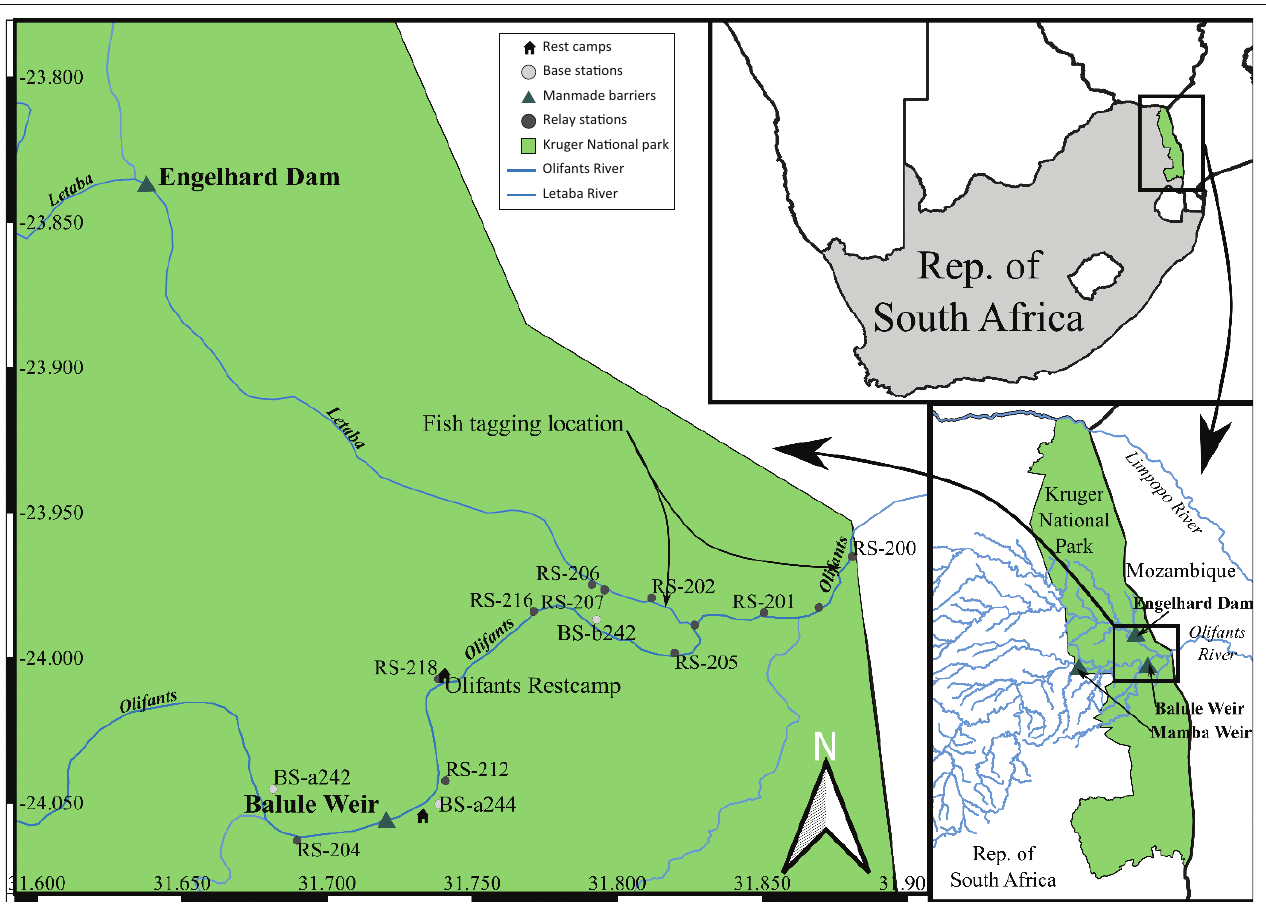
FIGURE 1: The Kruger National Park within South Africa and the positioning of the remote network consisting of base and relay stations. The hydrological gauging weirs at Balule and Engelhardt on the Olifants and Letaba Rivers, respectively, are shown.